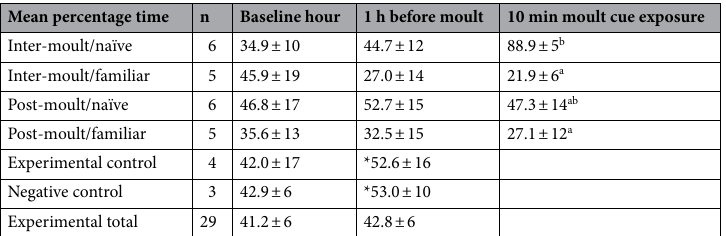
Table 2. Mean percentage time lobsters spent in the conspecific conditioned current of the choice arena for four treatment groups and two control groups. Mean values ± sem. n = number of replicates per treatment. *Analysis at 1 h before mean moult time. No upstream moults occurred in controls treatments. Lower case letters denote statistically similar treatment groups during 10 min moult cue exposure.